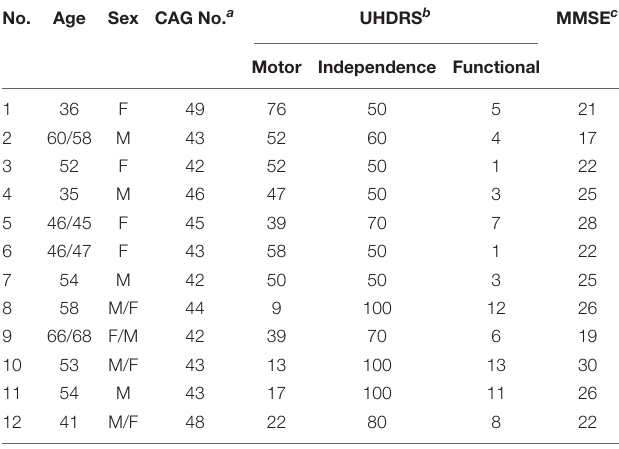
TABLE 1 | Demographic description between patients with Huntington’s Disease (HD) and healthy